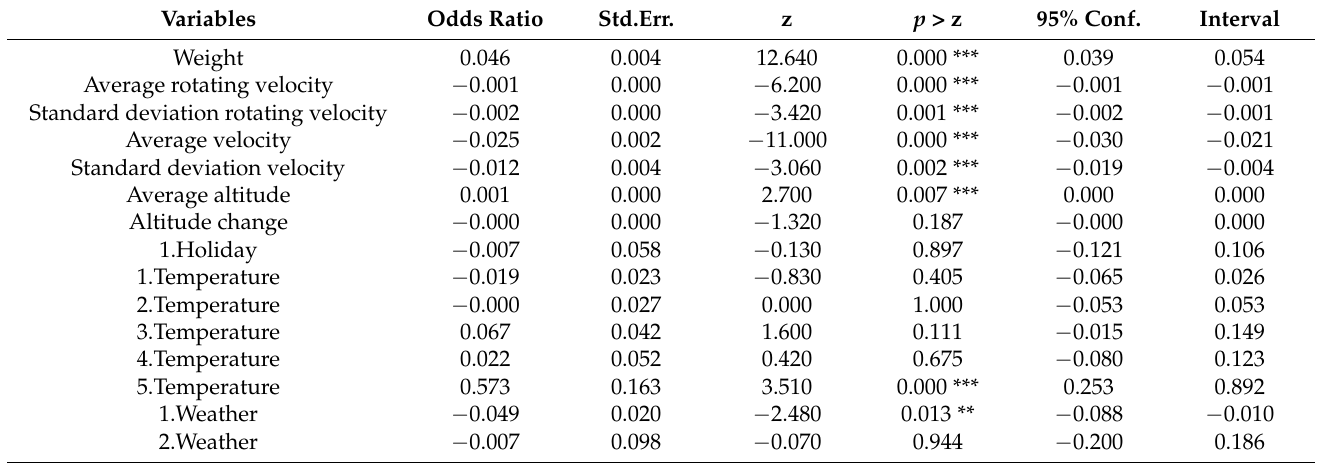
Table 7. Results of marginal